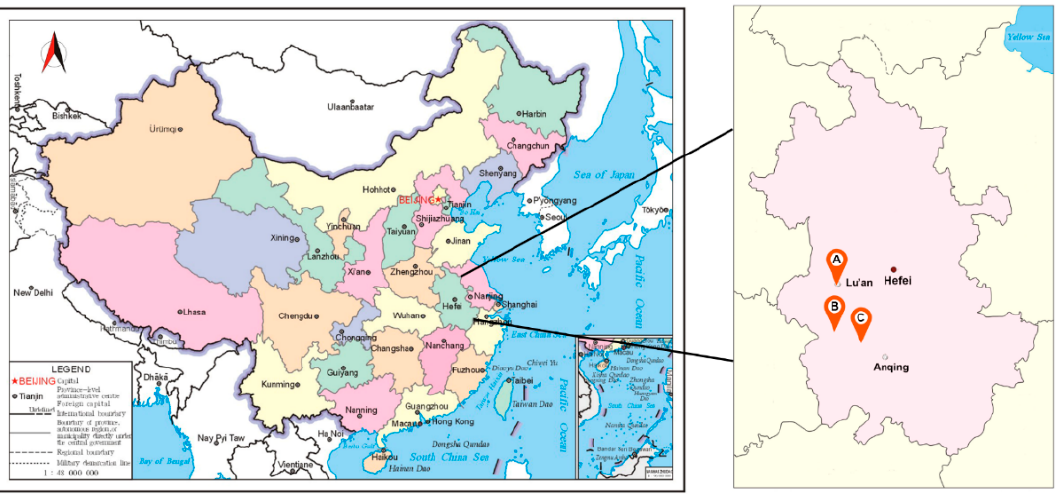
Figure 1. Location map of different cultivation modes of Dendrobium officinale . Maps from Standard mapping service system of Ministry of Natural Resources of China (http://bzdt.ch.mnr.gov.cn/). ( A ) Greenhouse cultivation mode. ( B ) Bionic cultivation mode. ( C ) Wild cultivation mode.